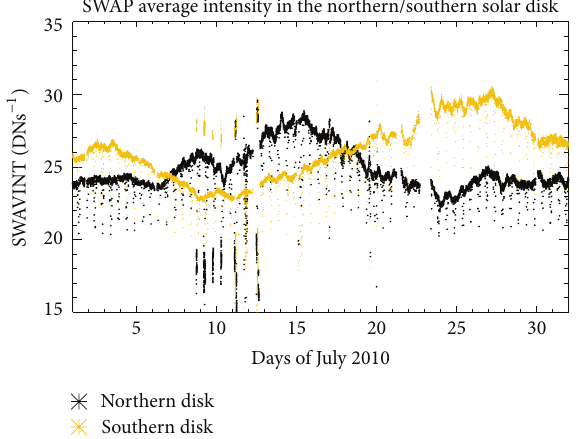
Figure 7: SWAP average intensity variations in the northern and southern solar disk in July 2010.